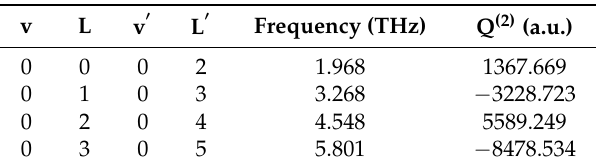
Table 1. Reduced matrix elements of the operator Q (2) for the transitions (v = 0,L) → (v ′ = 0,L ′ = L + 2) with 0 ≤ L ≤ 3, in atomic units.